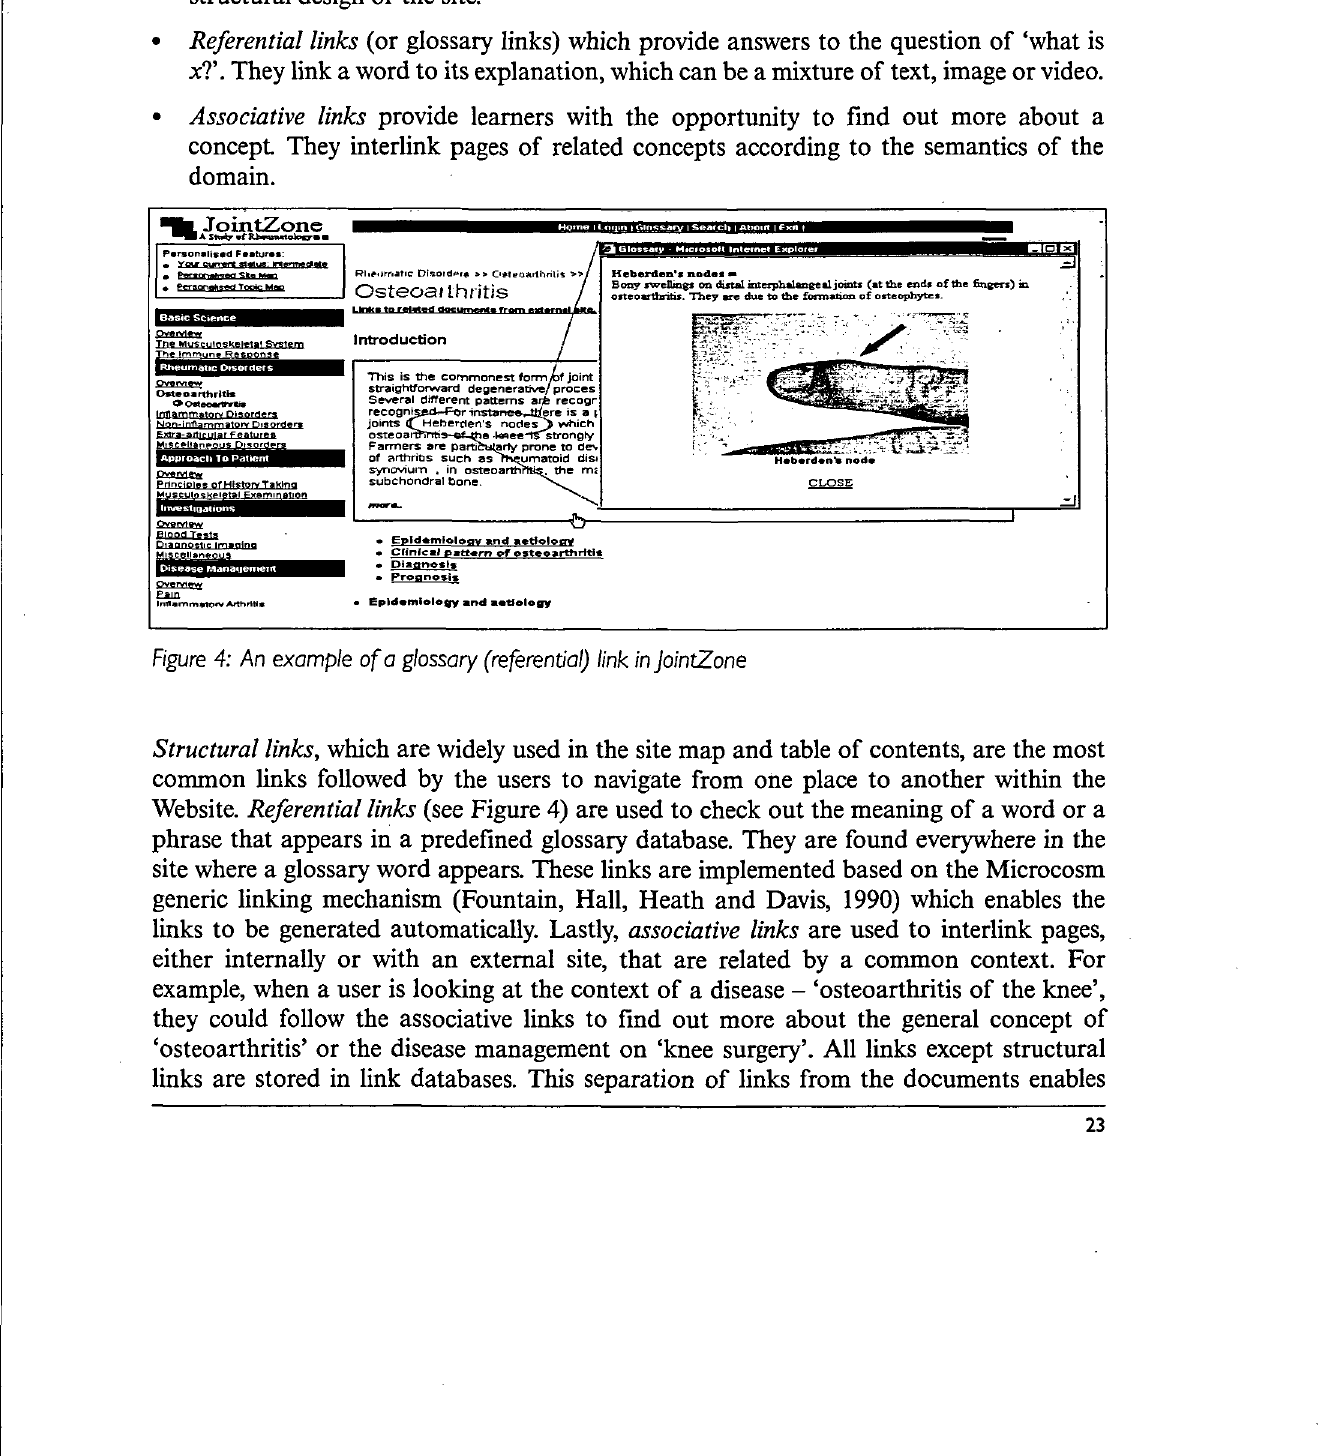
Figure 4: An example of a glossary (referential) link in